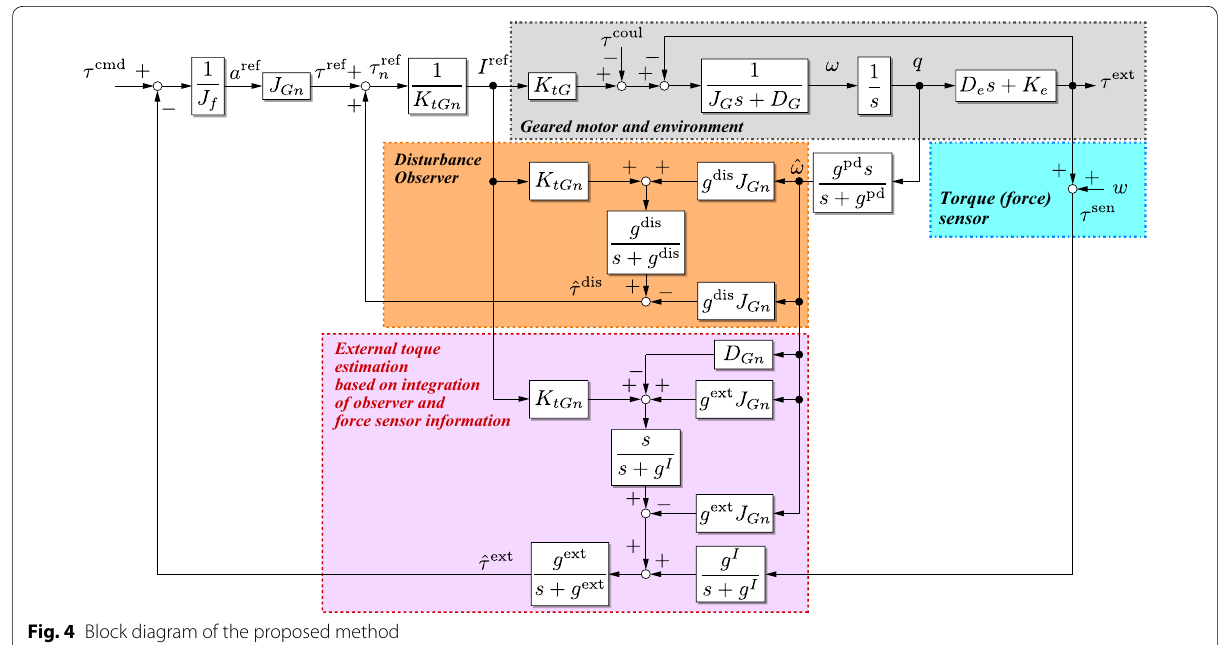
Fig. 4 Block diagram of the proposed method